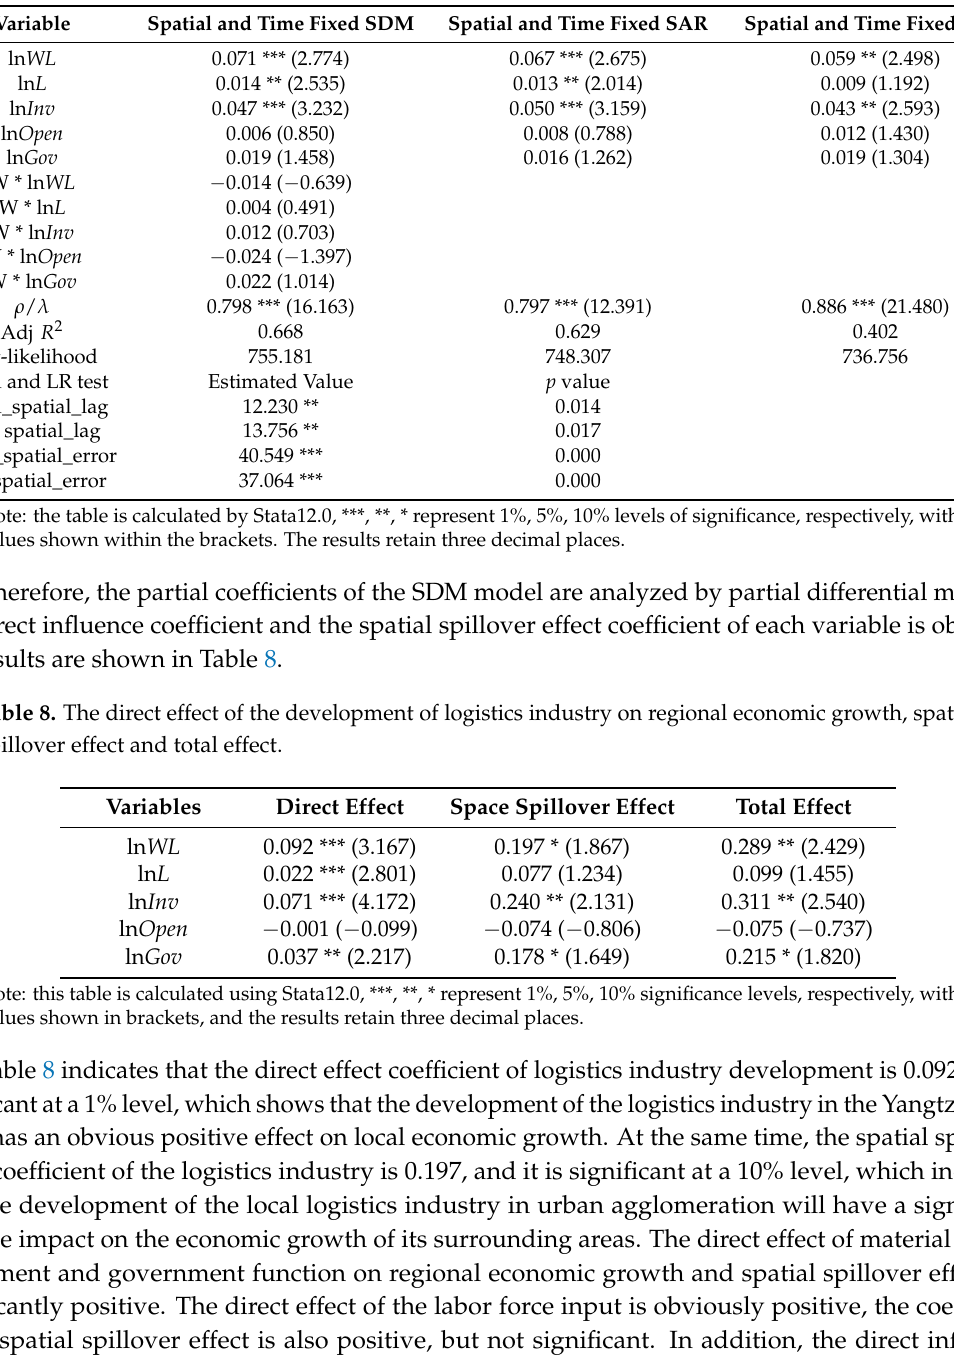
Table 7. Estimated results of spatial econometric models.